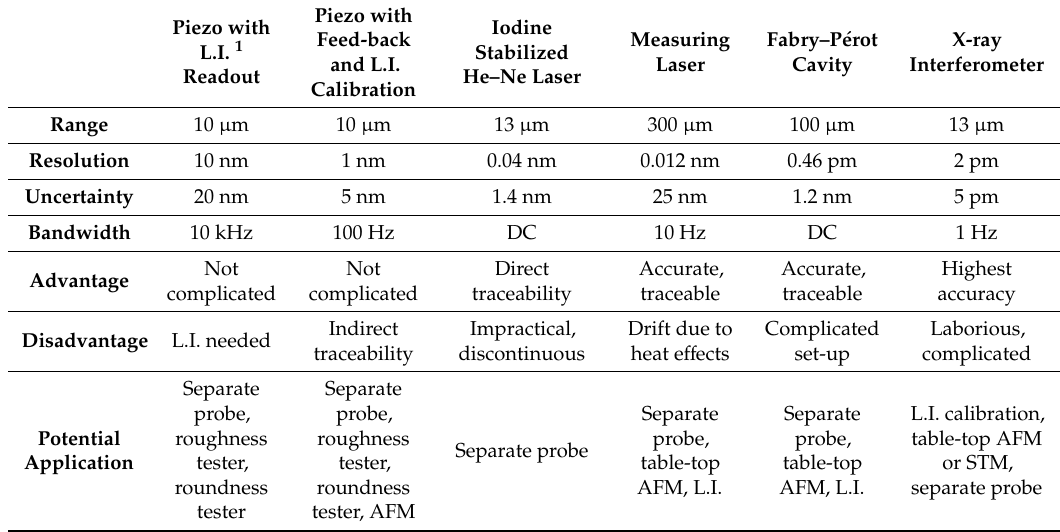
Table 1. Schematic overview of major sensor calibration